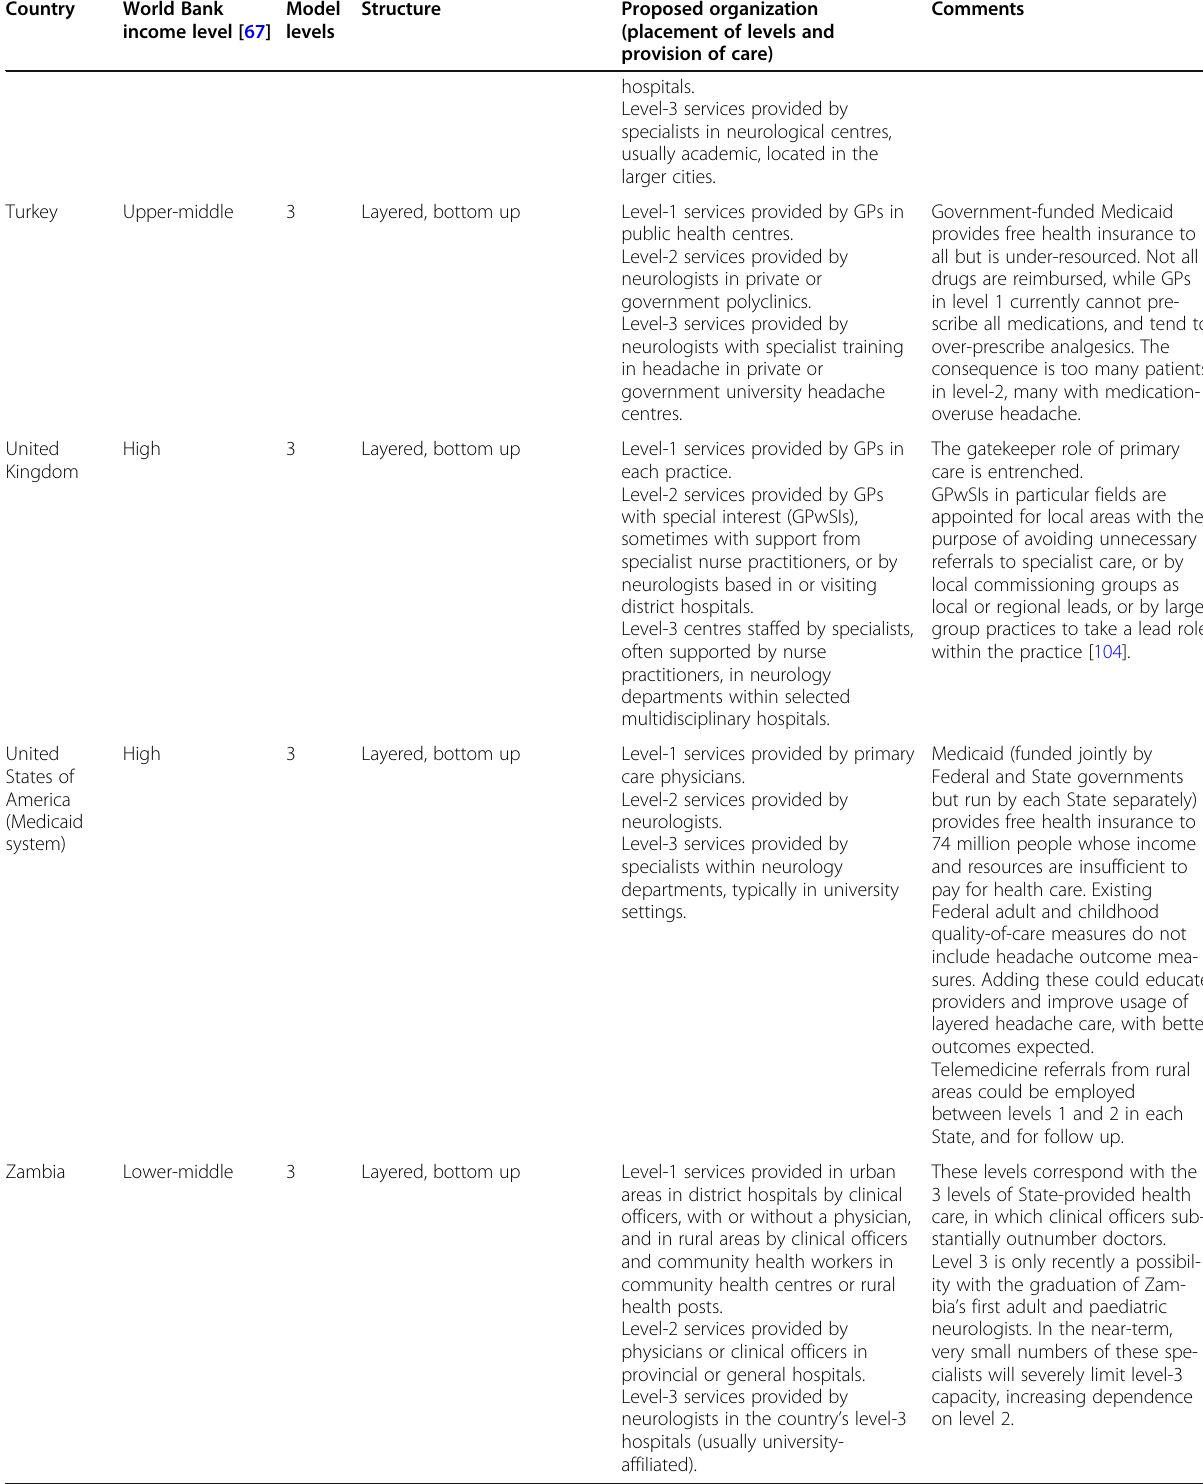
Table 7 Illustrations of how the model might be implemented, with adaptations, in various countries